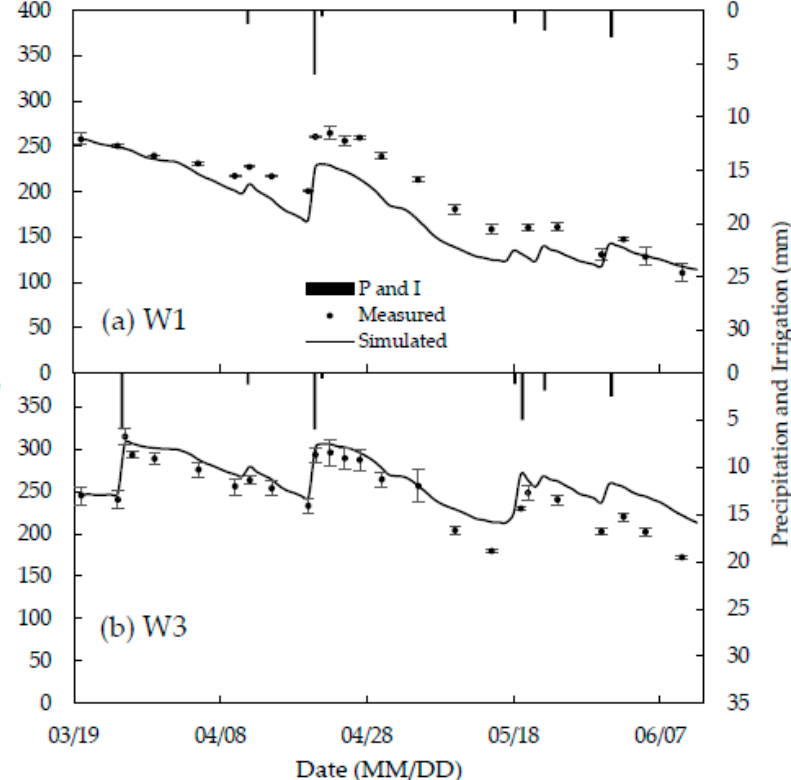
Figure 8. Comparison between simulated and measured soil water storage in 0–1 m soil layer in validation treatments.